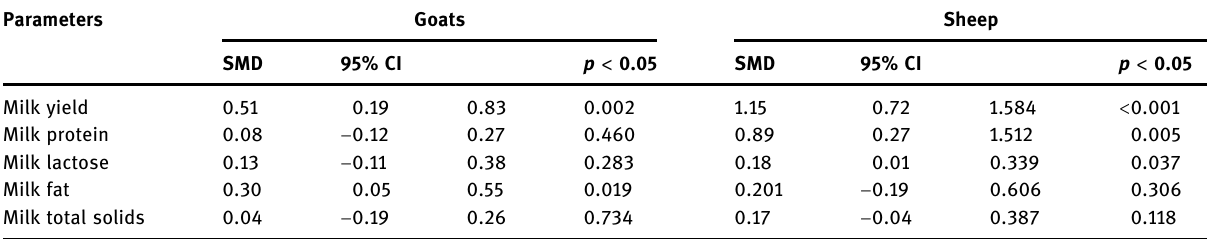
Table 3: E ff ect of ruminant type on milk yield and components in small ruminants fed SC supplemented diets Parameters